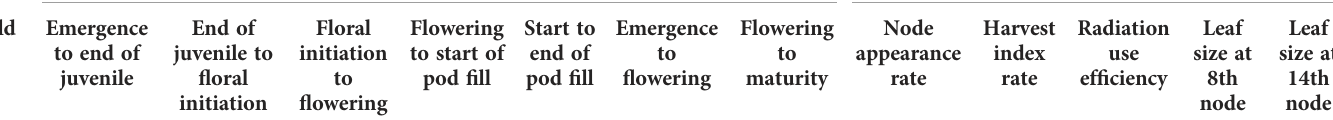
TABLE 2 The relationship between yield and phenological and physiological